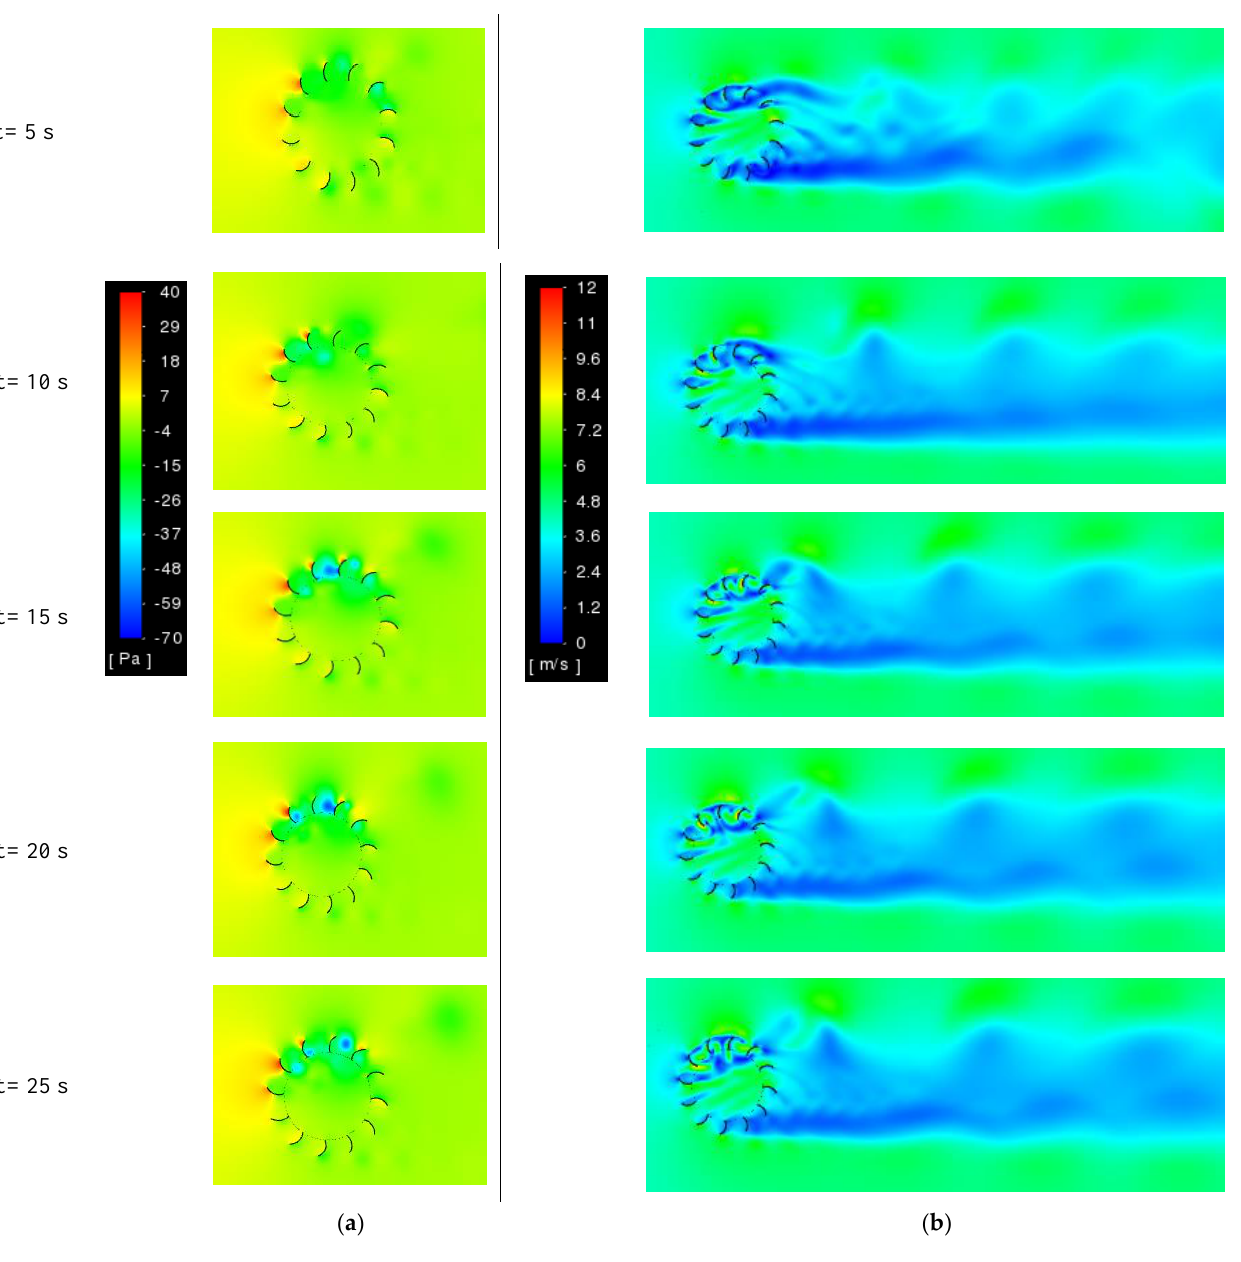
Figure 7. ( a ) Static gauge pressure and ( b ) flow velocity magnitude variations in the vicinity of the VAWT without stator.